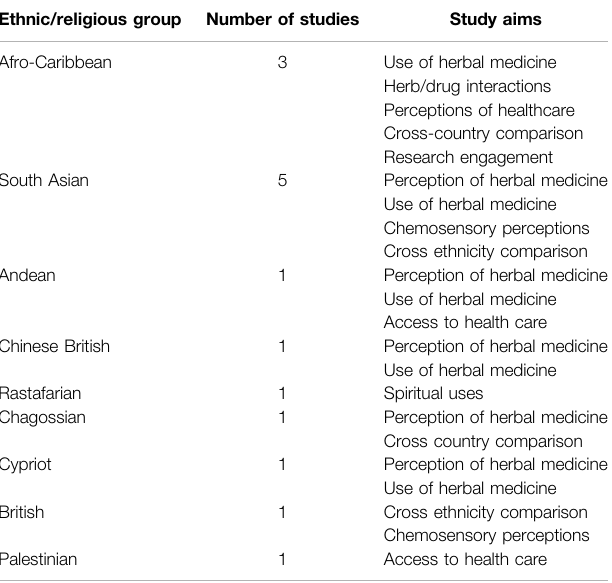
TABLE 2 | Study aims for the studies associated with the population theme of ethnic/religious group. Ethnic/religious group Number of